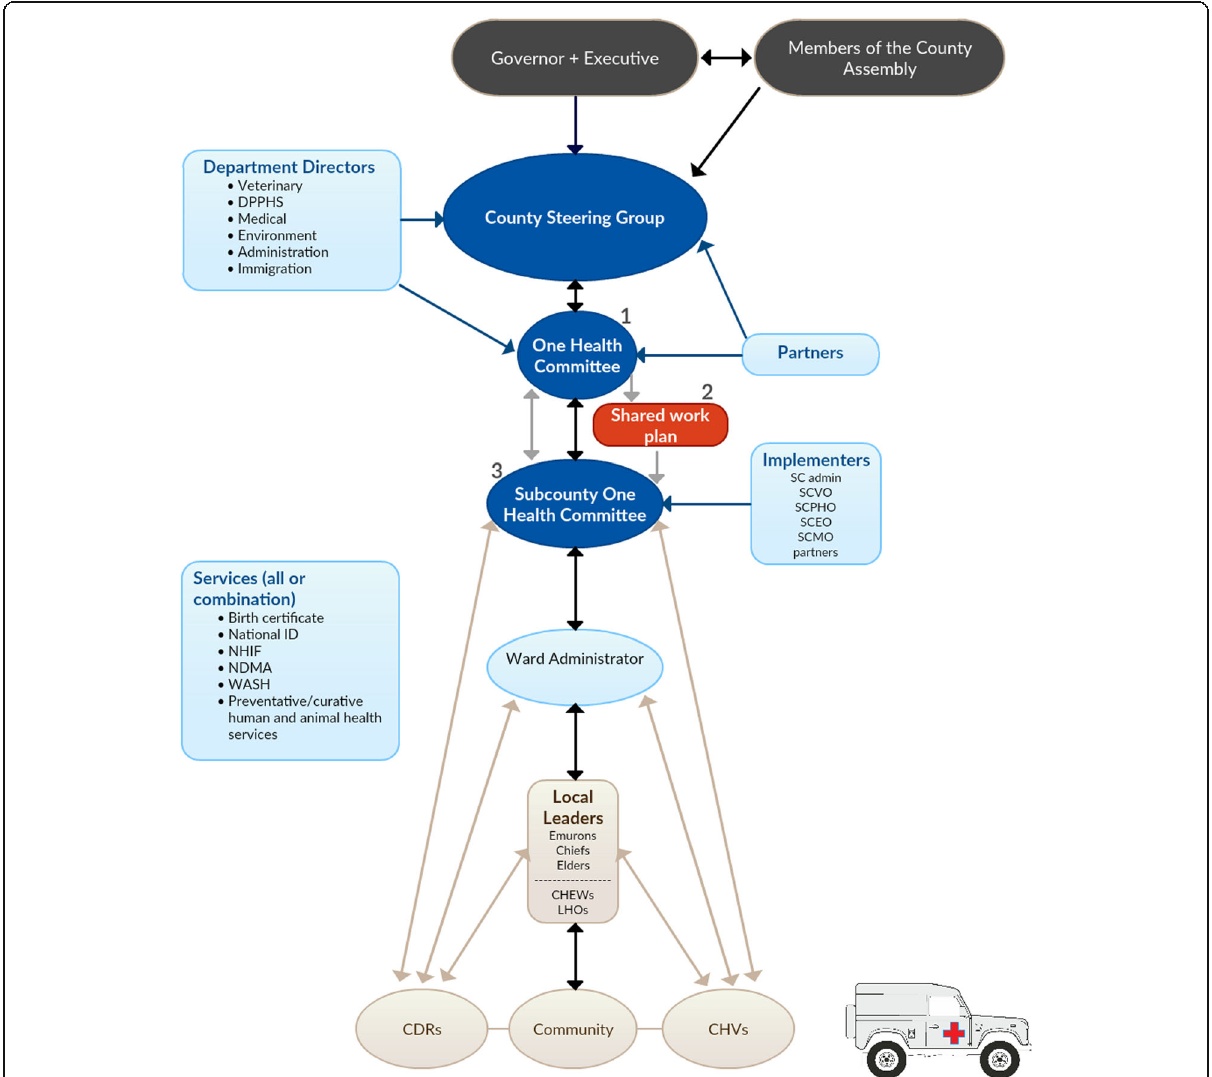
Fig. 2 A proposed One Health framework (OHF) for integrated service delivery. New components of service delivery are indicated by numbers: (1) One Health Committee (OHC) at the county level made up of department directors and partners in the human and animal health sectors; (2) shared work plan created through intersectoral collaboration on the county OHC; (3) subcounty OHC made up of subcounty officers (e.g. subcounty administrator, subcounty veterinary officer (SCVO), subcounty public health officer (SCPHO), subcounty environmental officer (SCEO), and implementing partners). Remaining officials and structures currently exist in Turkana. Arrows indicate suggested workflow of integrated service delivery and communication. Suggested services to be jointly delivered are